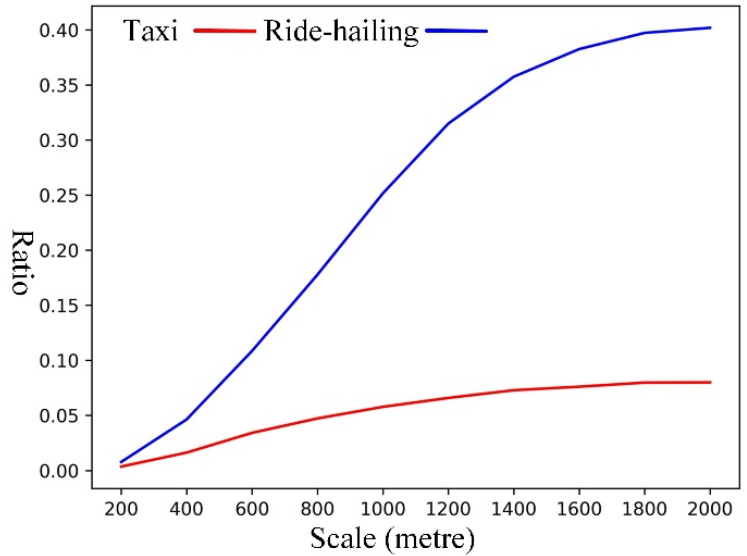
Figure 9. The percentage of flows that exhibit strong spatial associations.